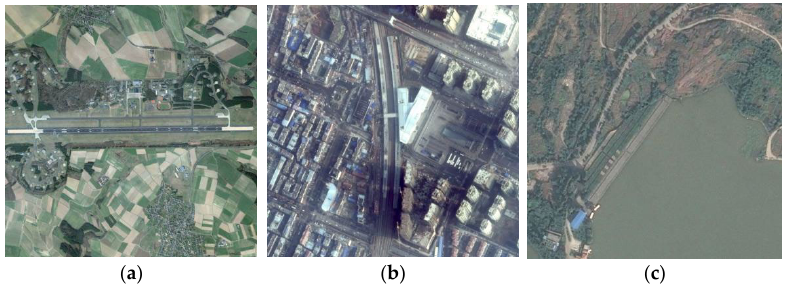
Figure 1. Remote sensing images in DIOR dataset, ( a ) contains ‘Bridge’, ( b ) contains ‘Overpass’, ( c ) contains ‘Dam’, which have similarities with other classes. contains ‘Dam’, which have similarities with other